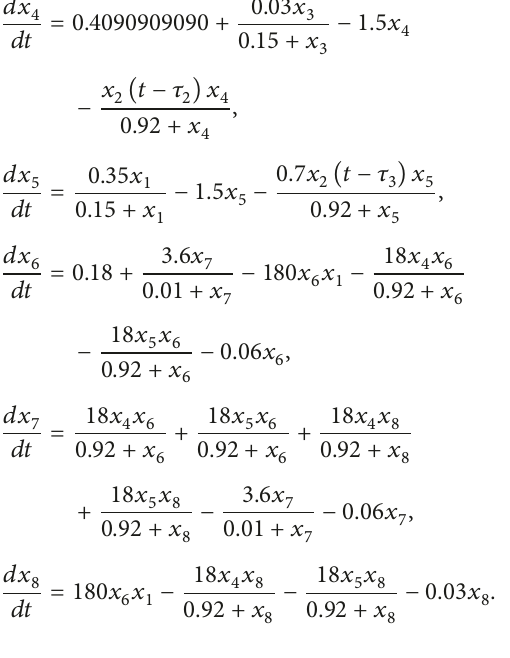
Figure 8: A periodic solution bifurcated from equilibrium for 𝜏 = = 0, 𝑥 = 0, 𝑥 = 𝜏 = 𝜏 = 𝜏 > 𝜏 2 3 4 1 2 3 0 . Assume initial conditions are = 2.5 . 0, 𝑥 = 0, 𝑥 = 0, 𝑥 = 0, 𝑥 = 0.55, 𝑥 21 3 4 5 6 𝑆 = 3, 𝑘 = 2.5 21